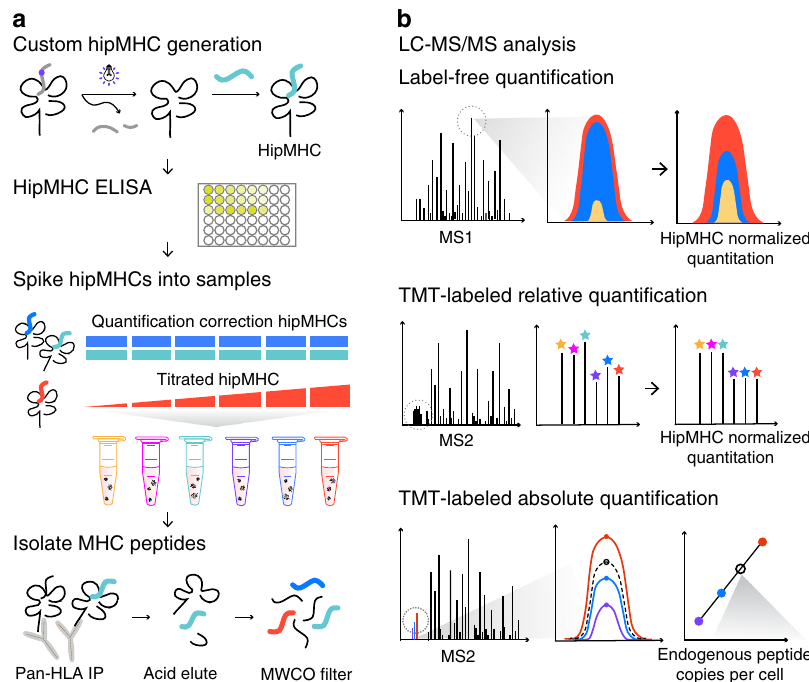
Fig. 1 Platform for quantitative immunopeptidomics using hipMHCs. a HipMHCs were generated through UV-mediated peptide exchange of HLA*A2:01 monomers with a heavy leucine HLA-A*02:01 binding peptide. Stable hipMHCs concentrations were measured with an ELISA, and hipMHC complexes were added to lysate samples prior to immunoprecipitation (IP), at the same concentration for quanti fi cation correction (blue/teal) or titrated in to create an internal standard curve (red). Heavy and light pMHCs were isolated with IP, acid elution, and molecular weight cut-off (MWCO) fi lters. b Peptides were analyzed by LC-MS/MS three ways. Relative quanti fi cation label-free analyses were quanti fi ed by integrating the area under the curve (AUC) of the chromatographic elution across samples, and quanti fi cation was normalized by applying correction factors determined by hipMHC AUC intensity ratios between samples. Samples for multiplexed analysis were TMT-labeled and relative quanti fi cation was implemented using reporter ion intensities. Normalization was performed using hipMHC reporter ion intensity ratios across TMT channels. For absolute quanti fi cation, TMT-labeled samples containing a hipMHC internal standard curve were used to calculate the endogenous copies per cell of the pMHC of